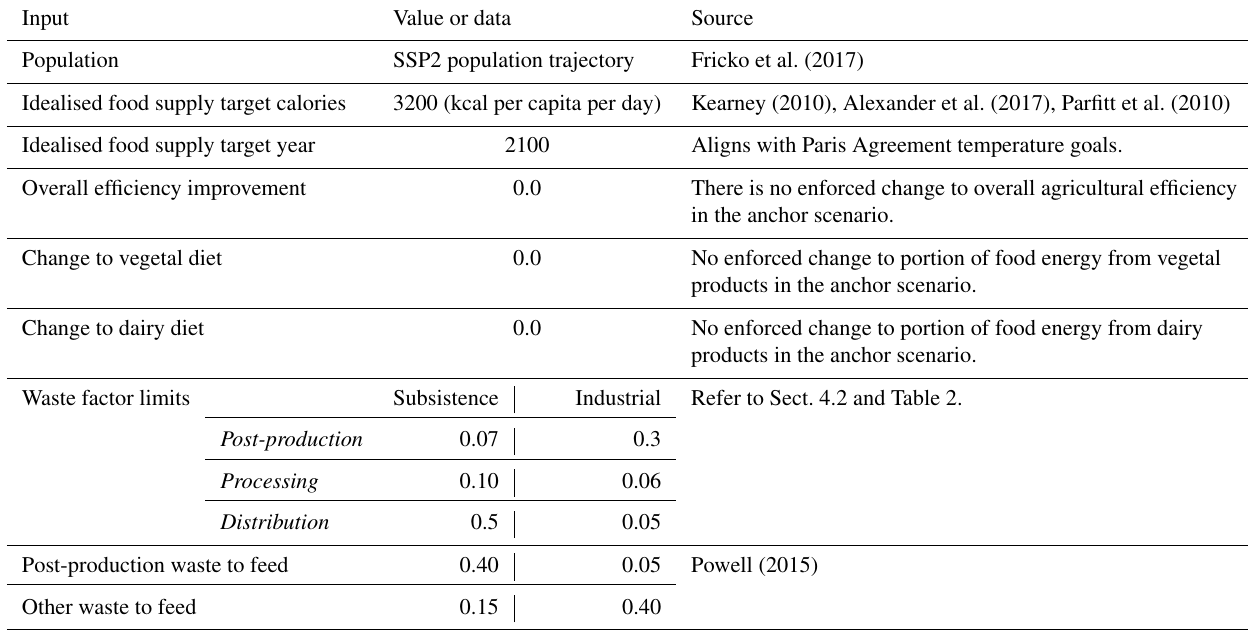
Table D1. Inputs, values, and data used to produce the anchor scenario in